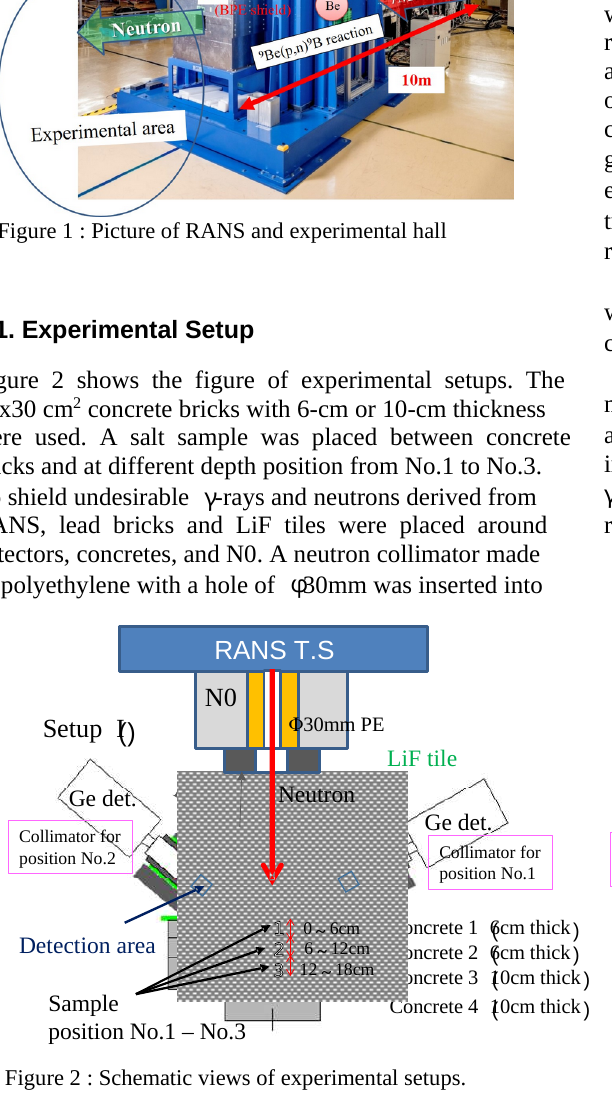
Figure 2 : Schematic views of experimental